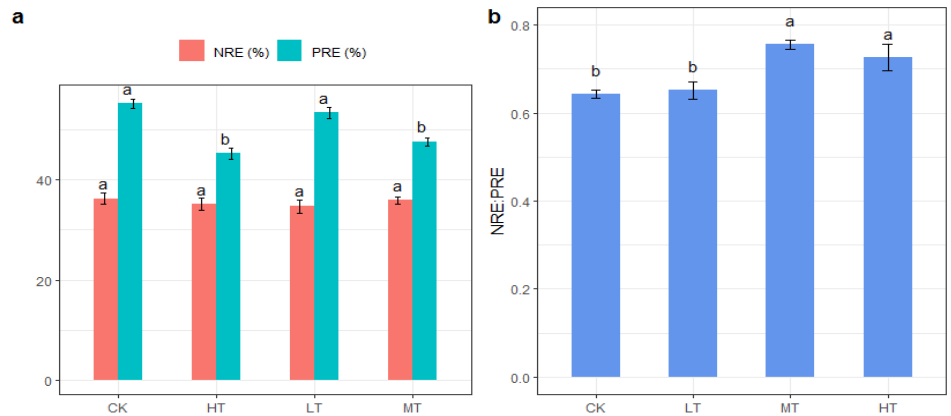
Figure 5. Changes in NRE, PRE ( a ), and NRE:PRE ( b ) among different thinning treatments. Different letters indicate significant differences among different thinning treatments ( p < 0.05)